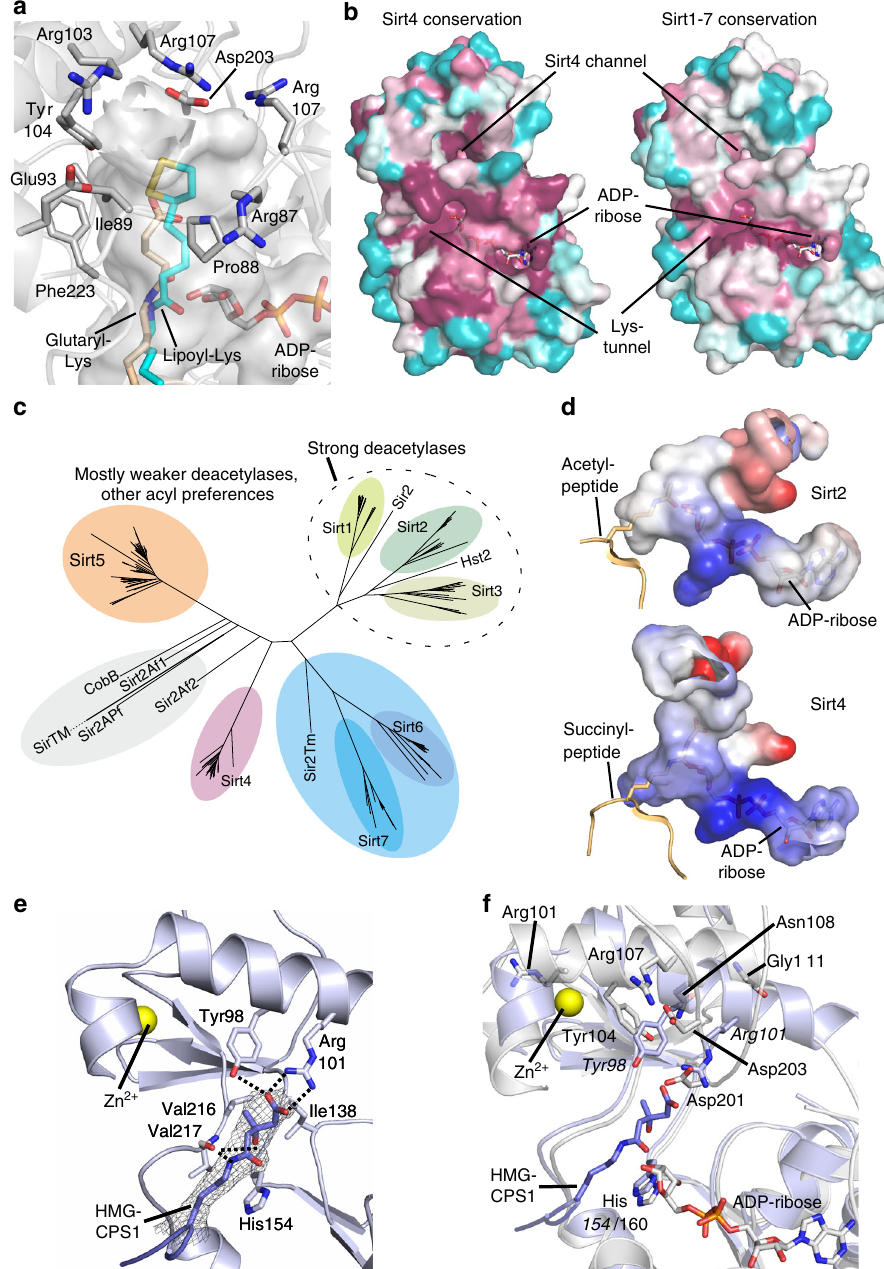
Fig. 3 Sirt4 structural features and phylogeny. a xSirt4 active site with the additional Sirt4 channel to the acyl pocket shown as transparent surface. ADPr and residues forming the channel are shown as sticks colored according to atom type. Glutaryl-Lys (beige) from an overlaid Sirt5 complex (PDB ID 4UTR) indicates the conventional acyl pocket, and the modeled lipoyl-Lys (cyan) the bottom of the Sirt4 channel. b xSirt4 surface colored according to sequence conservation within Sirt4 isoforms (left; from higher eukaryotic Sirt4 in UniProt) and within the complete Sirtuin family Sirt1 – 7 (right; from chordate Sirt1 – 7 in UniProt). Purple indicates high conservation, cyan high variability. c Phylogenetic tree generated from a structure-based sirtuin alignment, extended by aligning 195 chordate sirtuin sequences (see Supplementary Fig. 2c for a core alignment). d Active site inner surface of Sirt4 and Sirt2 (PDB ID 5D7O; see Supplementary Fig. 3d for all isoforms) colored according to electrostatic potential (red: − 15 to blue:+15 k B T/e ). The succinyl- and acetyl-peptide are from overlays (PDB IDs 3RIY and 3GLR, respectively). e Crystal structure of zSirt5 in complex with HMG-CPS1 substrate peptide. Ligand and interacting residues are shown as sticks, and 2F o – F c electron density for the peptide is contoured at 1.0 σ . Dotted lines indicate hydrogen bonds. f Active site overlay of xSirt4/ADPr (gray) and zSirt5/HMG-CPS1 (blue). Catalytic His and residues analyzed for acyl recognition contributions are shown as sticks and labeled (italics: sirtuins form a cluster in the Sirt5 branch, separate from chordate Sirt5 and almost equidistant to Sirt4. The Sirt6/7 branch also comprises a prokaryotic member, Sir2Tm. The three subclusters for the strong deacetylases Sirt1, 2, and 3 are clearly separated from the other branches but contain yeast enzymes, indicating